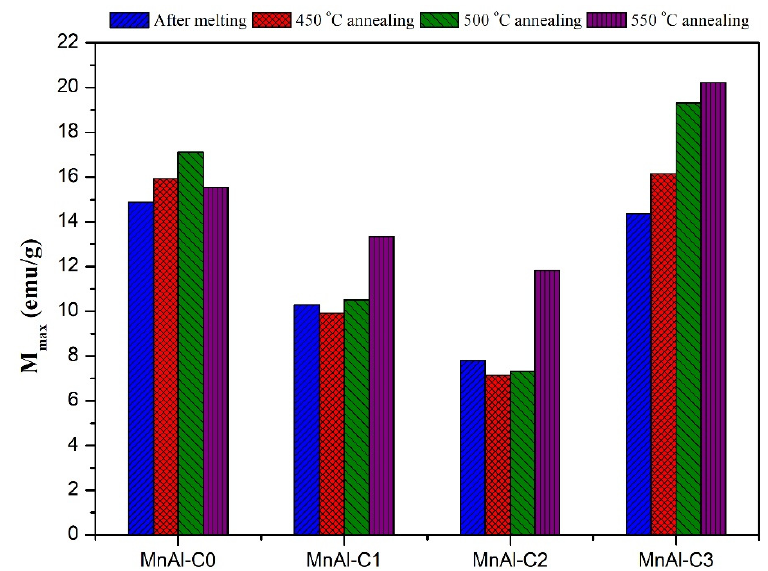
Figure 6. Maximum magnetization (M max ) of (Mn 55 Al 45 ) 100-x C x powders before and after annealing for 20 min at 450, 500, and 550 °C under argon atmosphere.